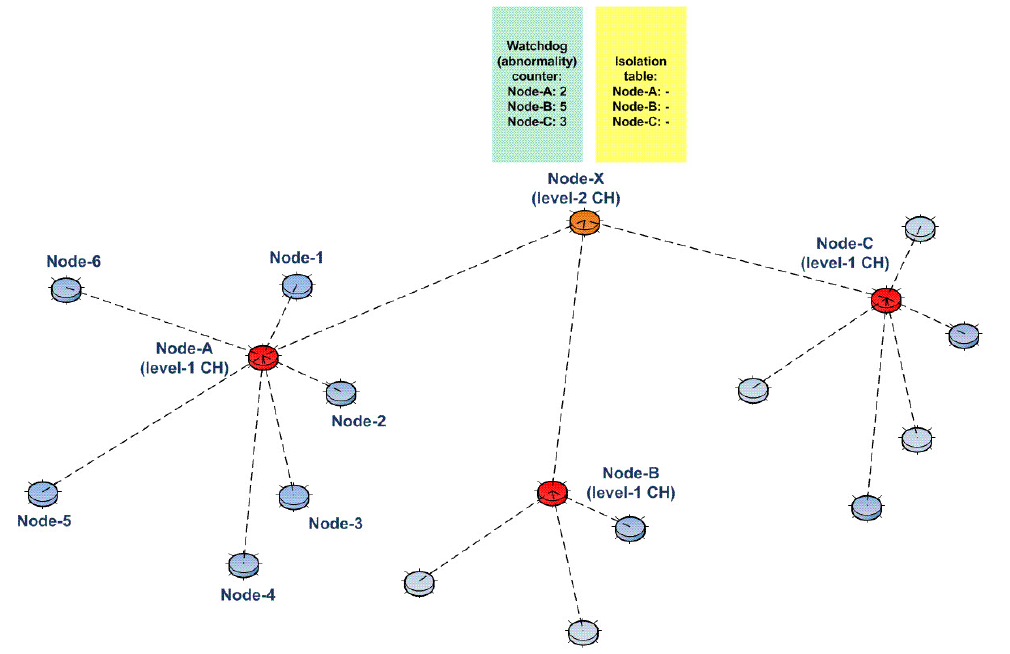
Figure 5. Implementation of D-IDS for upper levels of the